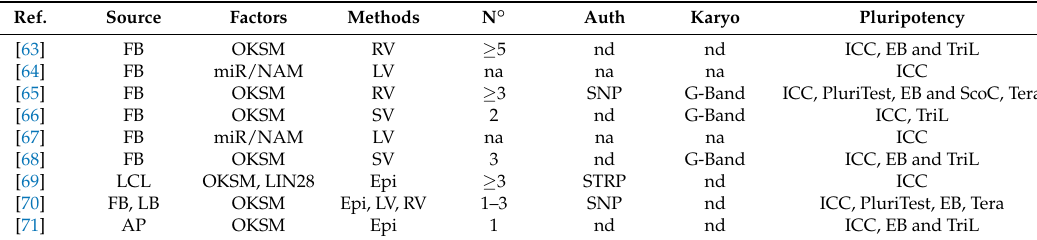
Table 1. Methods for iPSC generation and quality control in BD studies.